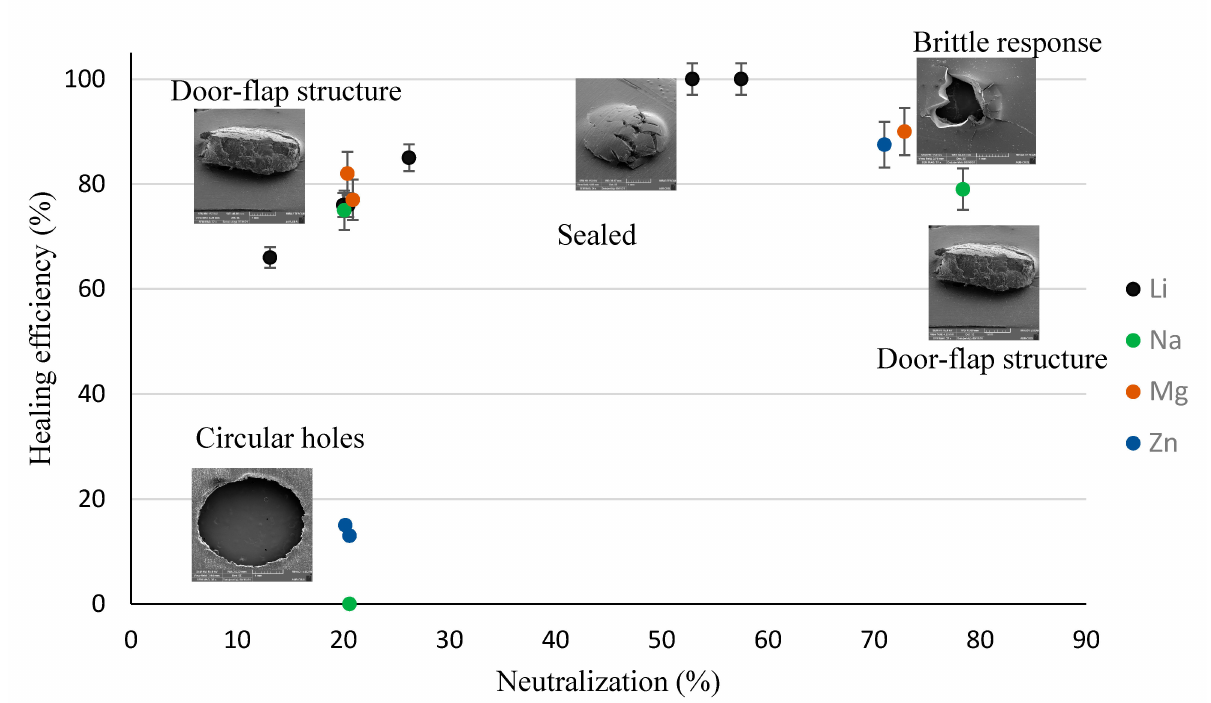
Figure 15. Healing efficiency obtained using Equation (1) as a function of neutralization percentage and ion